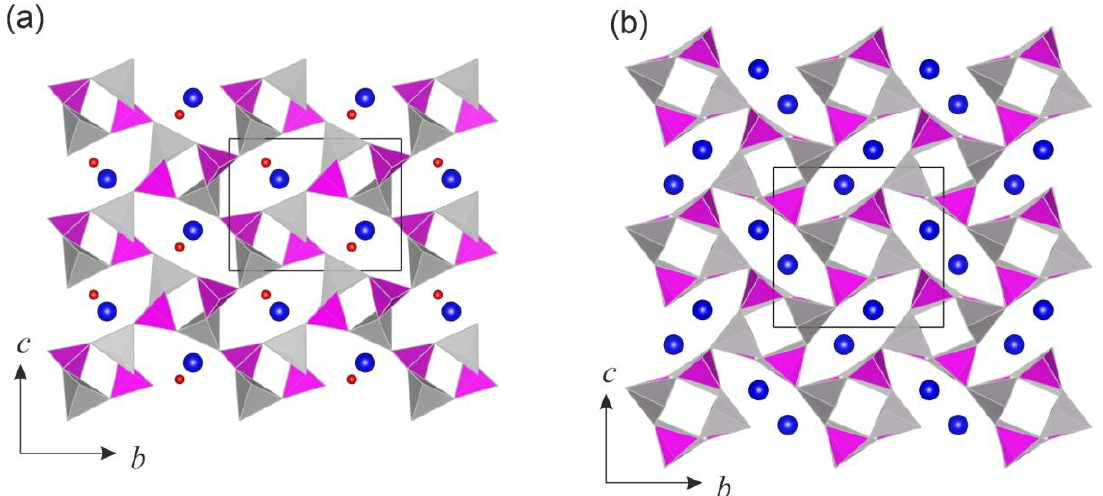
Figure 3. Crystal structure of BaAs 2 Zn 2 O 8 · H 2 O ( a ) and BaAs 2 Zn 2 O 8 ( b ) under ambient condition. AsO 4 and ZnO 4 tetrahedra are given in purple and grey, respectively. Ba and O atoms are presented as blue and red spheres, respectively.